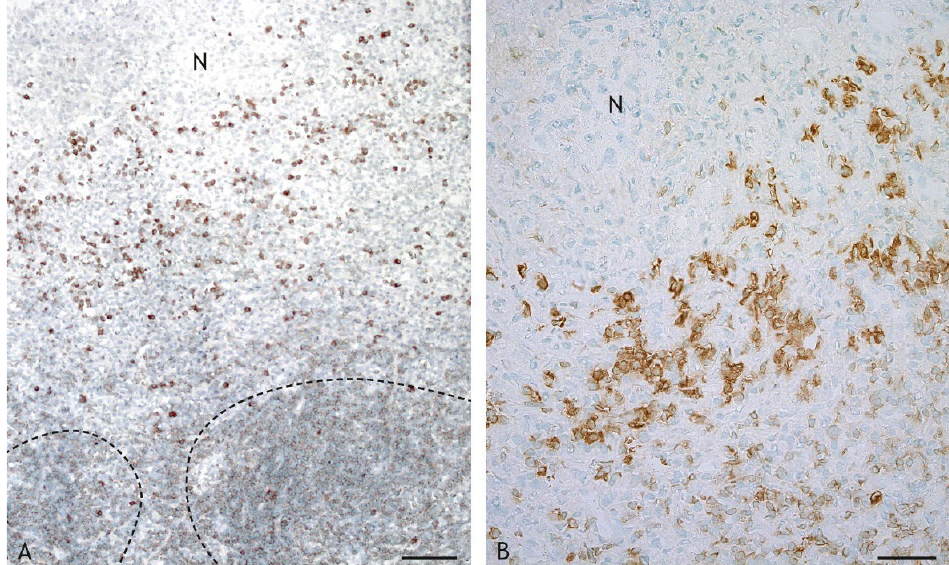
Figure 15. B cells and plasma cells in the inflammatory infiltrate of granulomas with central necrosis (N). ( A ). BCG-induced granuloma, goat 13: B cells (weak labelling) form follicle-like structures in the periphery of the inflammatory infiltrate (indicated by a hatched lines). ( B ). PDX-induced granuloma, goat 19: groups of plasma cells (intensely labelled cytoplasm) are present adjacent to the central necrosis (N). IHC, CD79 α . Scale bar in ( A ) = 100 µm, scale bar in ( B ) = 50 µm.